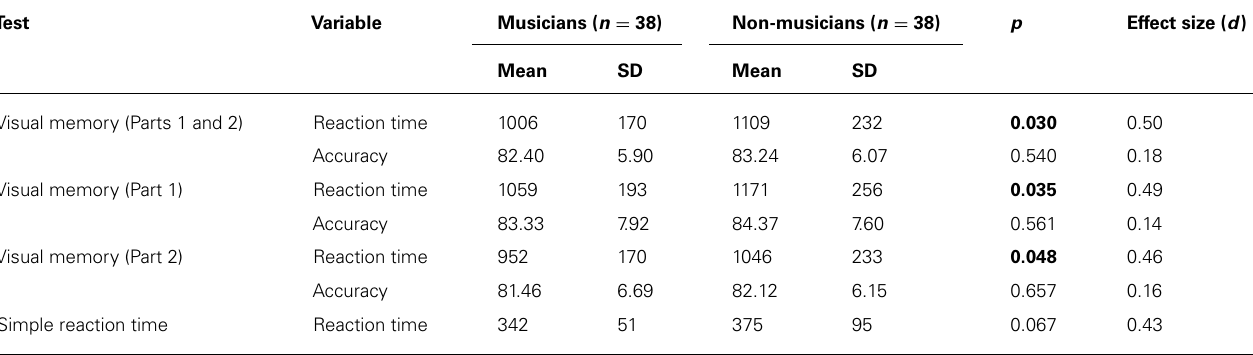
Table 1 | Comparison between musicians and non-musicians in the visual memory test and in the simple reaction time test. Test Variable Musicians ( n = 38) Non-musicians ( n = 38) p Effect size ( d )